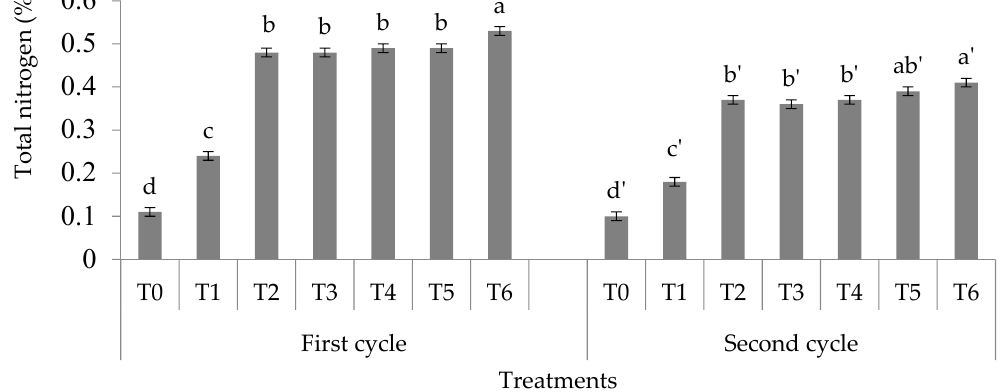
Figure 1. Effects of treatments on soil total nitrogen. Means with the same letter above the bars within a crop cycle are not significantly different at p ≤ 0.05. Bars represent the mean values ± standard error .